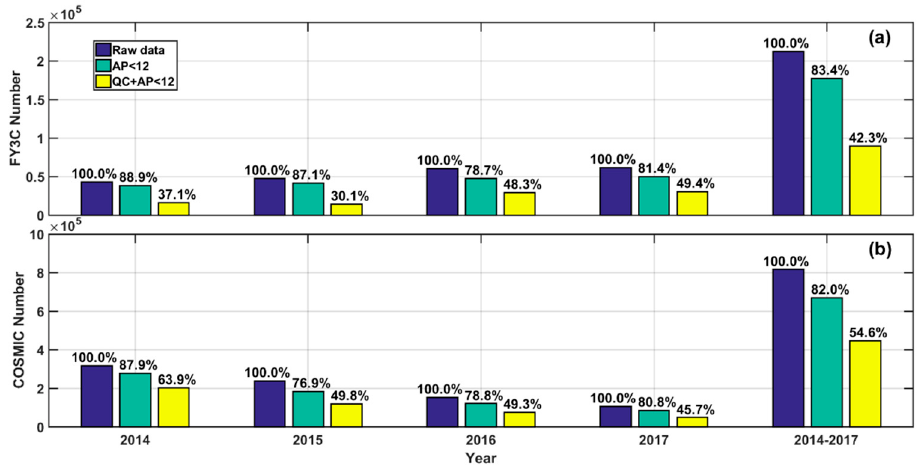
Figure 2. Variations of the numbers and the percentage of RO electron density profiles before and after the Ap index check and further after quality control for ( a ) Feng-Yun 3C (FY-3C); and ( b ) the Constellation Observing System for the Meteorology, Ionosphere, and Climate (COSMIC).